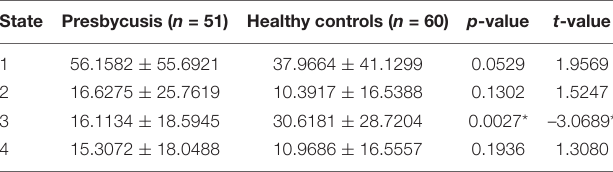
TABLE 3 | Two sample t -test of mean dwell time between the patients with presbycusis and the HCs.